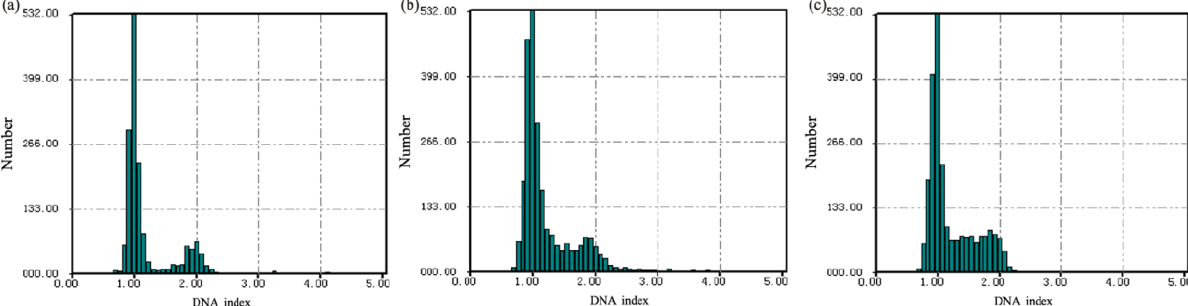
Figure 3: Cell cycles analyzed by DNA image cytometry. (a) DNA ploidy from NUC keratinocyte group showed: Diploid= 75.12%, Aneuploid= 9.47%, Quadploid=15.41%. (b) DNA ploidy from precancerous cell group showed: Diploid= 67.24%, Aneuploid= 21.49%, Quadploid= 11.27%. (c) DNA ploidy from Caski cell group showed: Diploid= 62.73%, Aneuploid= 23.42%, Quadploid=